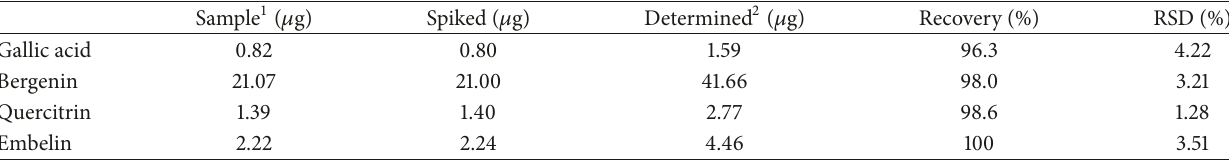
Table 3: Recovery (𝑛 = 6) for four analytes in